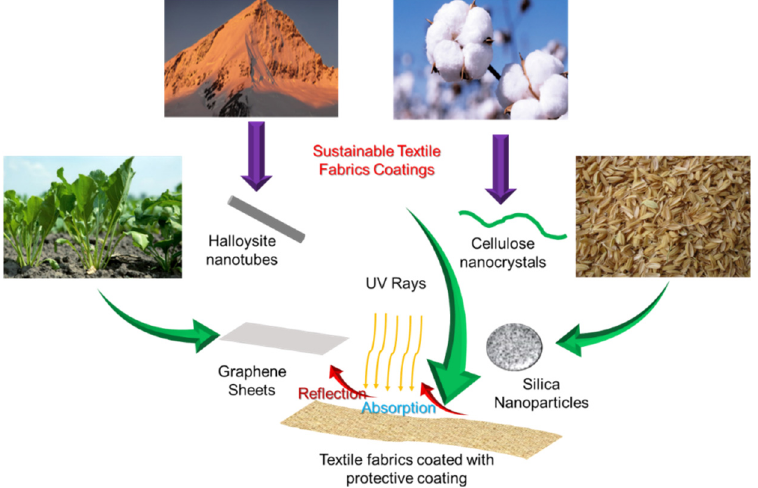
Figure 9. Schematic diagram representing the routes for sustainable textile fabric coatings and their UV rays blocking approaches.